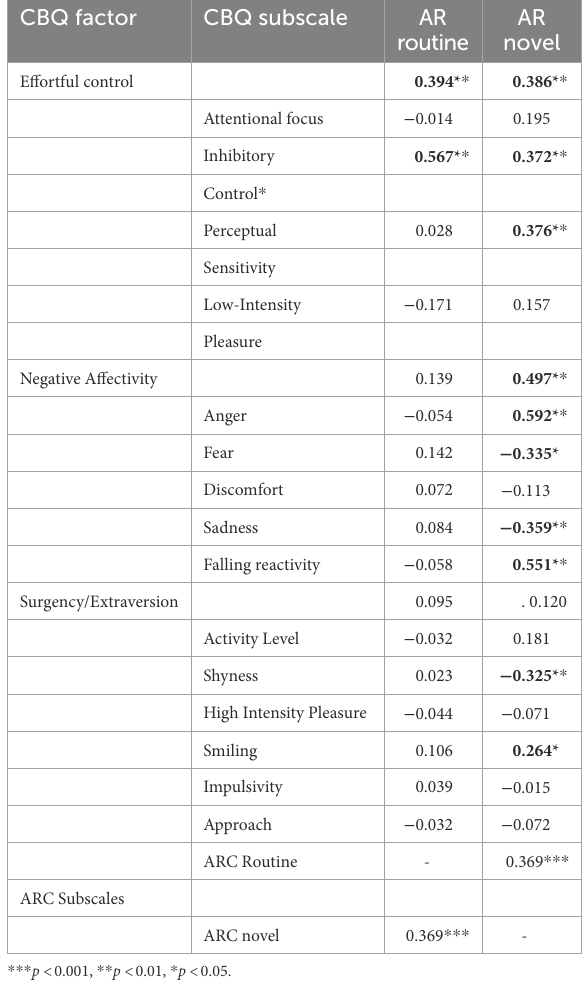
TABLE 2 Correlations between adaptive responsiveness in context subscales, ECT subscales, and SCBE subscales. Measures